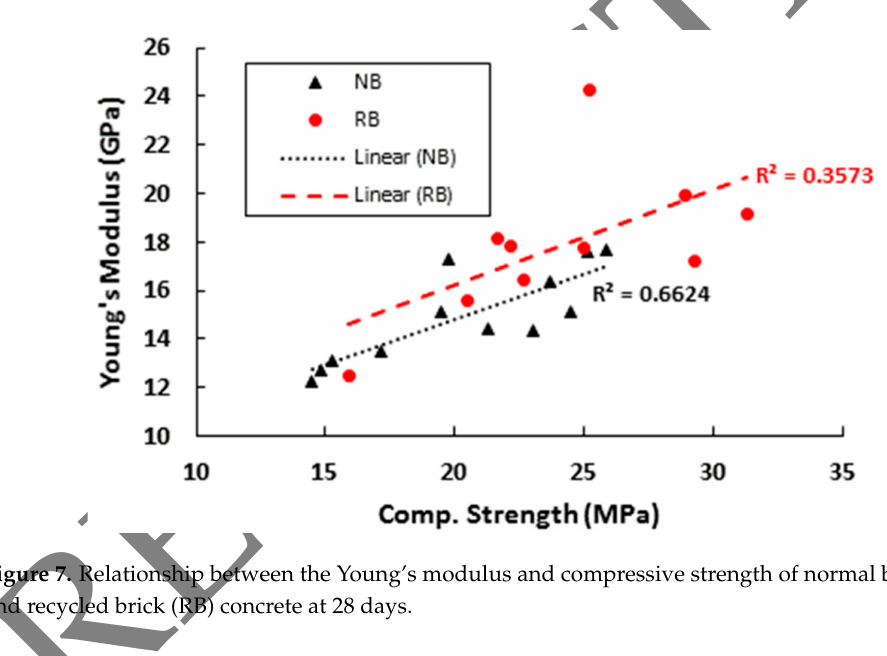
Figure 7. Relationship between the Young’s modulus and compressive strength of normal brick (NB) and recycled brick (RB) concrete at 28